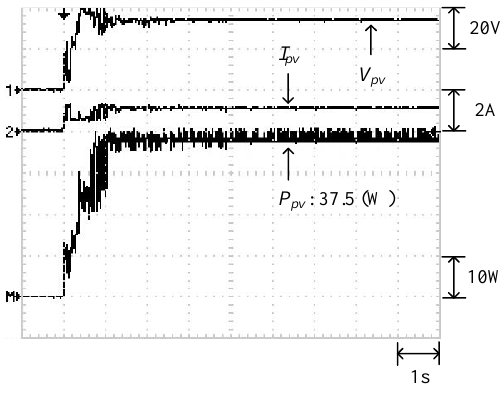
Figure 14. Maximum power point of Case 2 determined through the modified PSO algorithm.